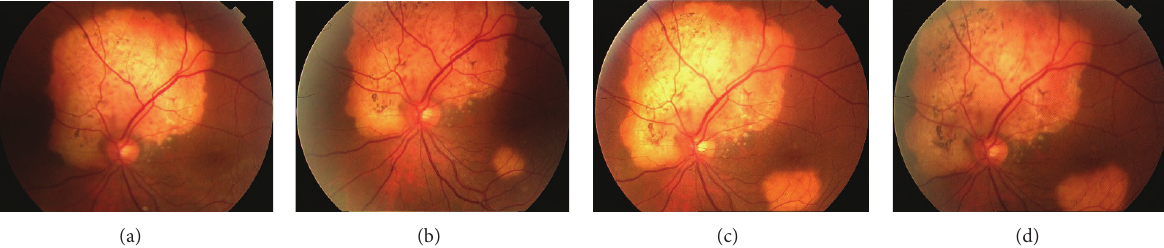
Figure 1: Evolution of the choroidal osteoma during the follow-up: (a) year 2004, (b) year 2011, (c) year 2013, and (d) year 2014.